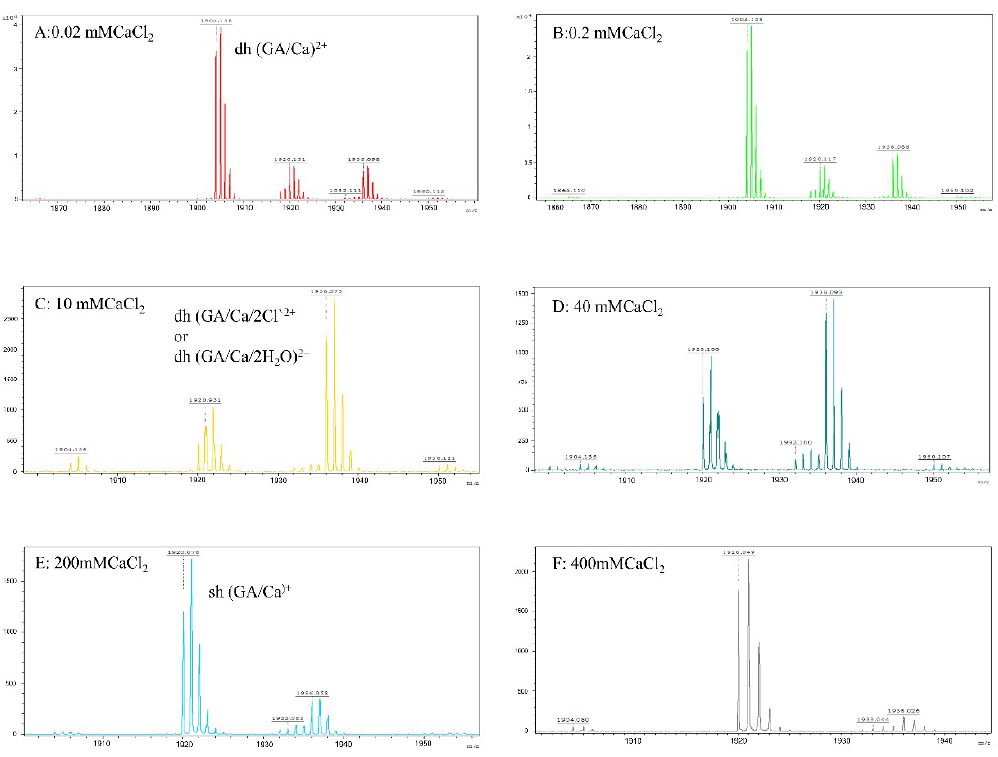
Figure 5. Mass spectra of gramicidin A in the presence of CaCl 2 . The samples containing 100 µ M gramicidin A with CaCl 2 at 0.02 ( A ), 0.2 ( B ), 10 ( C ), 40 ( D ), 100 ( E ) and 400 mM ( F ) in methanol were mixed with the matrix for mass analyses.